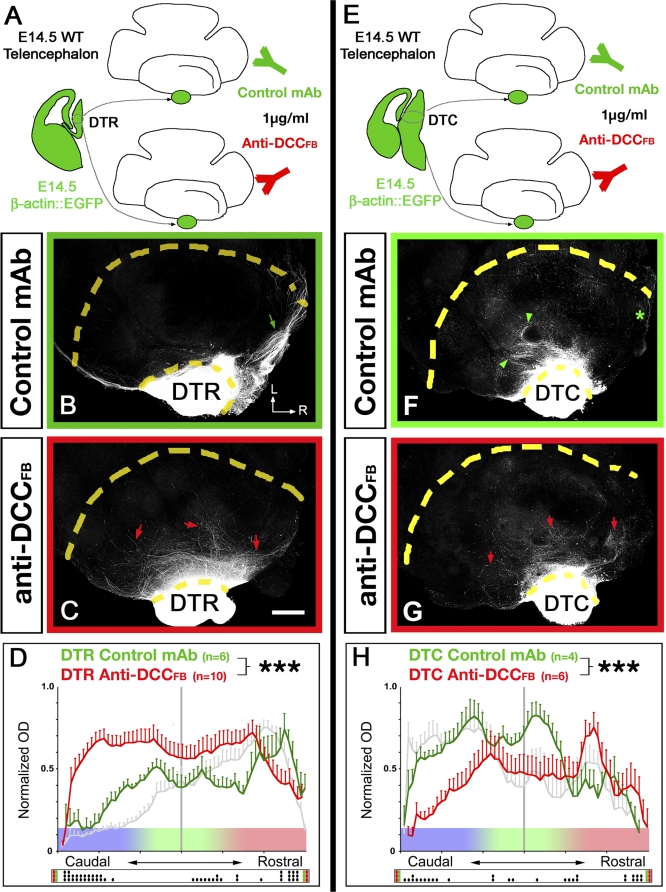
DCC Is Required for Both Attraction of Rostral Thalamic Axons and Repulsion of Caudal Thalamic Axons from the Netrin-1–Rich Rostral Domain of the Ventral Telencephalon(A and E) Isochronic whole-mount telencephalic cocultures with EGFP-expressing rostral (B–D) or caudal (F–H) DTh explants were incubated either with control isotype mouse IgG (B and F) or function-blocking anti-DCC monoclonal antibody (mAb) (C and G). Blocking DCC receptor function randomizes the outgrowth of both rostral and caudal DTh axons. L, lateral; R, rostral.(M) Quantification of normalized optical density (OD) of DTR-EGFP axons (D) or DTC-EGFP axons (H) growing in VTel with function-blocking anti-DCC antibodies (red curves) or control mouse anti-IgG antibodies (green curves). Triple asterisks (***) indicate p < 0.001, ANOVA one-way test (overall effect: bins versus experimental conditions). For comparisons, the gray curves represent the distribution of control DTR axons (in [D]) and control DTC axons (in [H]) cultured without antibody as shown in Figure 5D and 5H. The raster-like dot plot presented under each histogram represents the significance of individual bin comparisons performed between the two experimental conditions using a Fisher PLSD post hoc test (a single dot [•] indicates p < 0.05; double dots [••] indicate p < 0.01; and triple dots [•••] indicate p < 0.001).